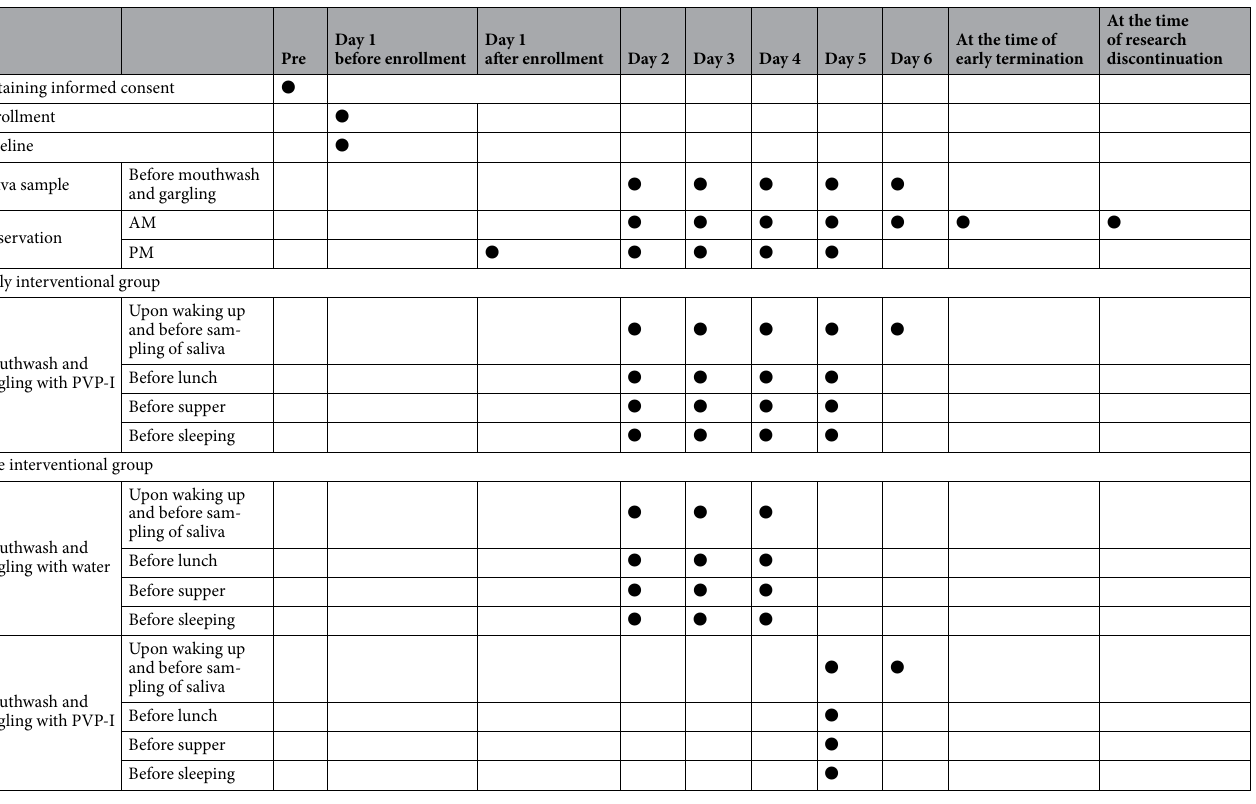
Table 1. The research schedule. ● : Required. Body temperature, presence or absence of physical condition changes, cough, suffocation, runny nose, stuffy nose, sore throat, nausea/vomiting, red-eye, headache, dullness, joint muscle pain, diarrhea, light-headedness/consciousness, miscellence, deemed